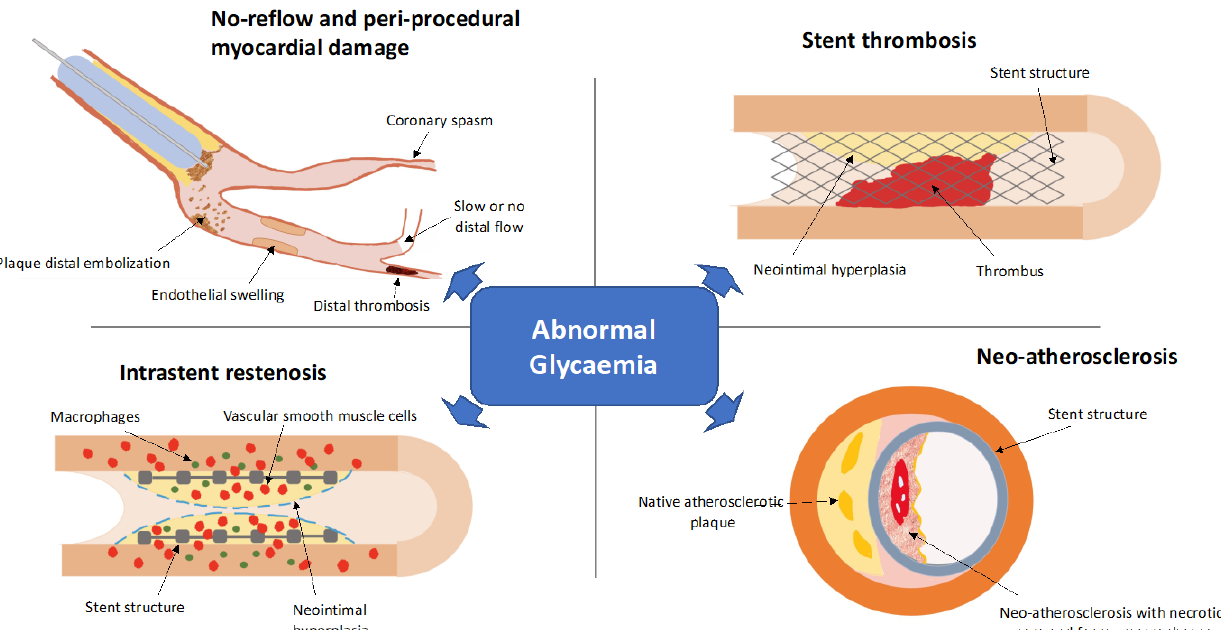
Figure 2. Peri-procedural and long-term stent-related complications favored by an abnormal gly- caemic status.